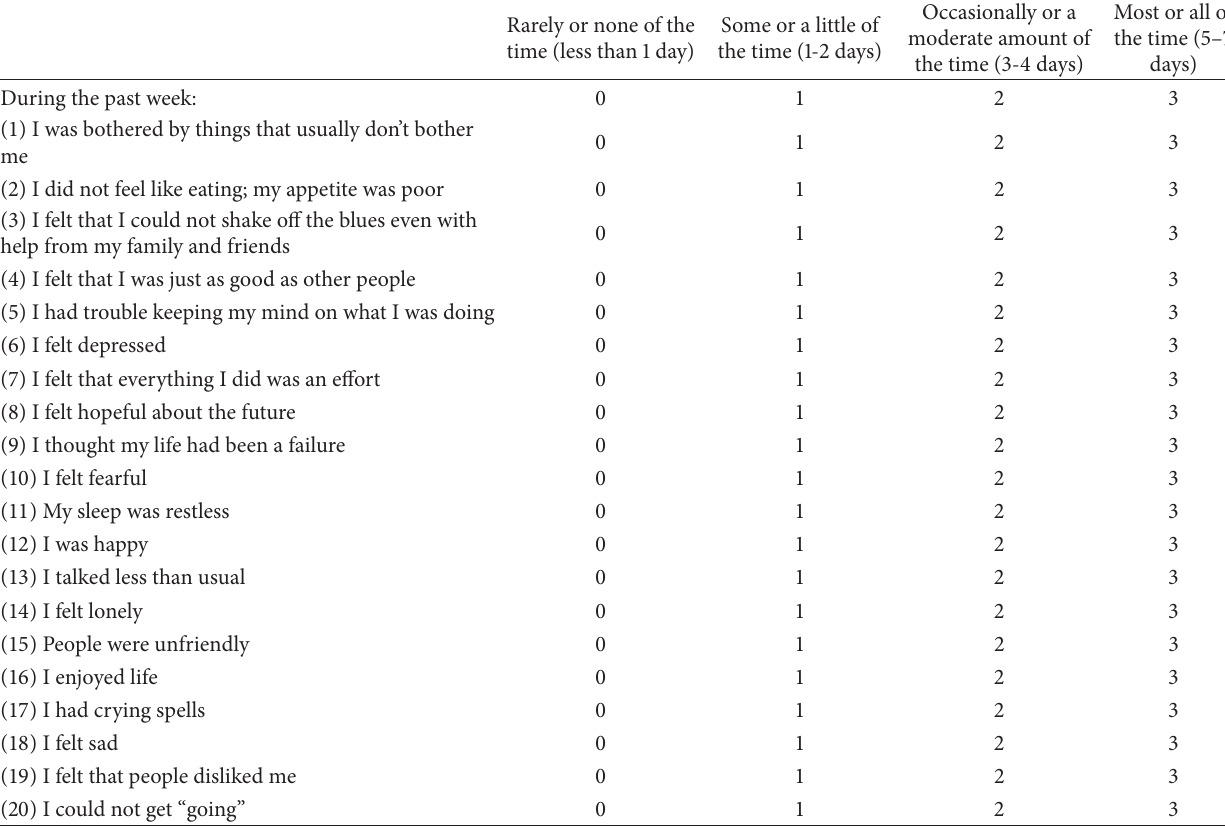
Table 5: Which best describes how often you felt or behaved during the last week? Rarely or none of